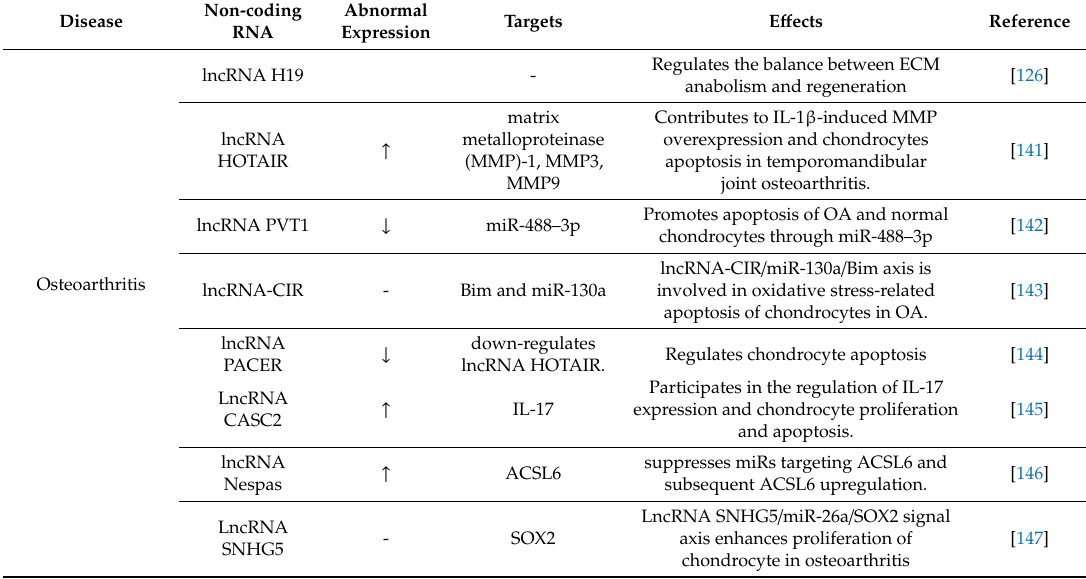
Table 3. The novel lncRNAs contribute to cartilage